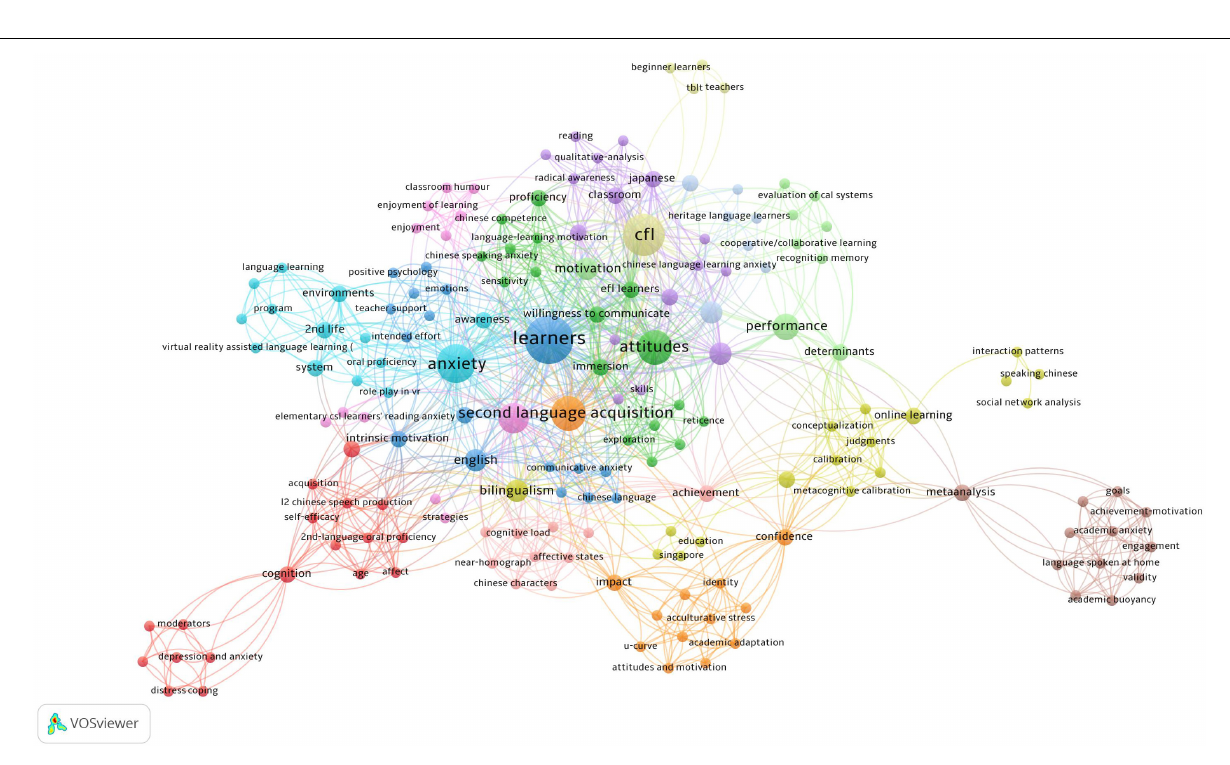
FIGURE 5 | Keywords co-occurrence in English language